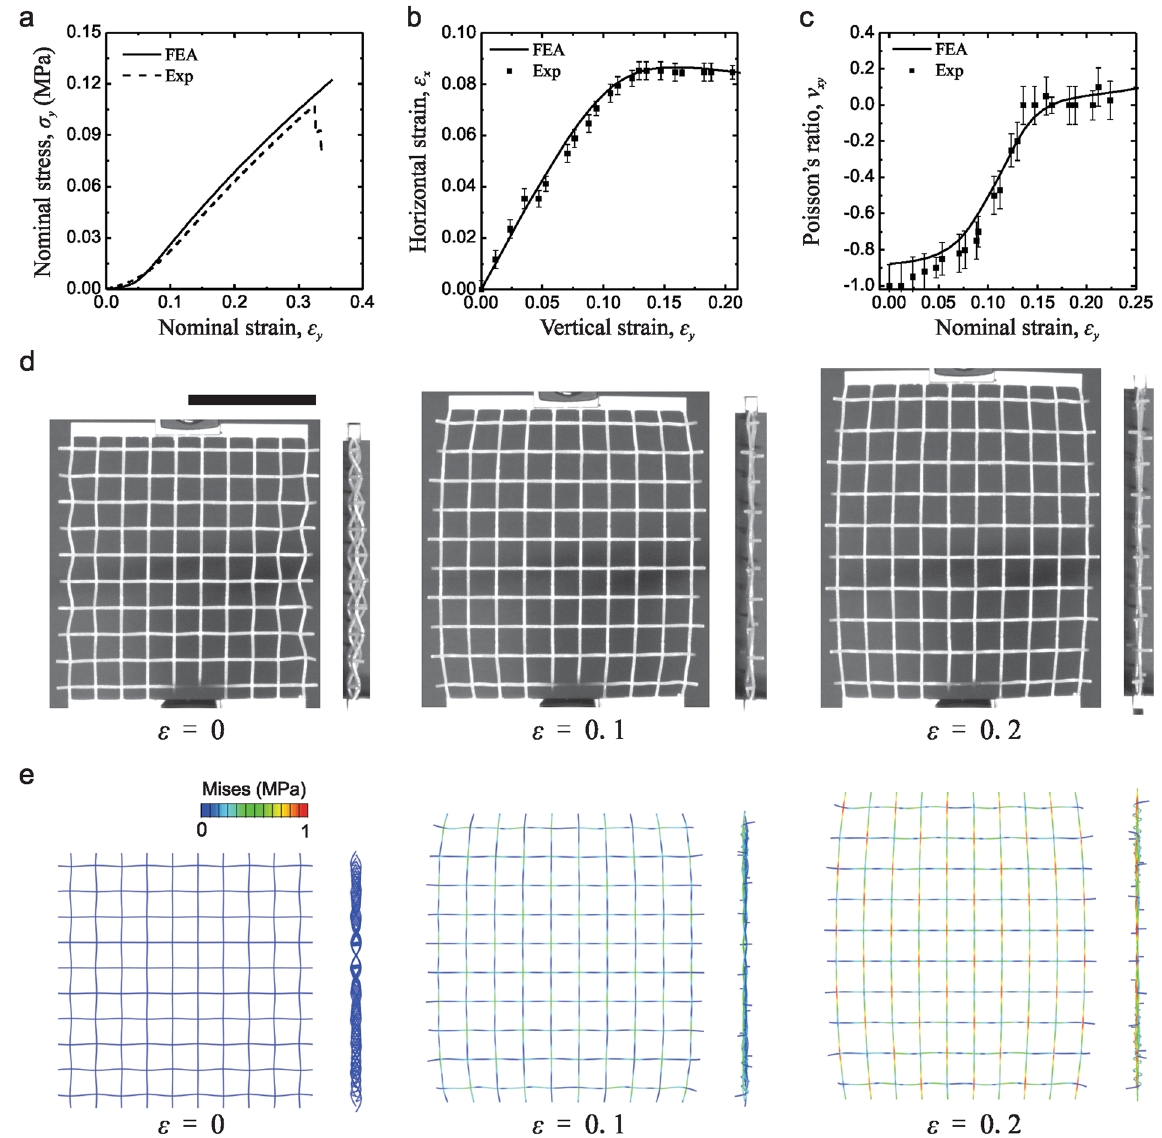
Figure 2. Experimental and FEA results of 3D planar auxetic metamaterials under uniaxial tensile tests: ( a ) nominal stress vs. nominal strain curve; ( b ) measured horizontal strain vs. vertical strain; ( c ) calculated incremental Poisson’s ratio curves as a function of nominal strain; ( d ) experimental and ( e ) simulation images at different levels of macroscopic strains: 0, 0.1, and 0.2. Scale bar: 5